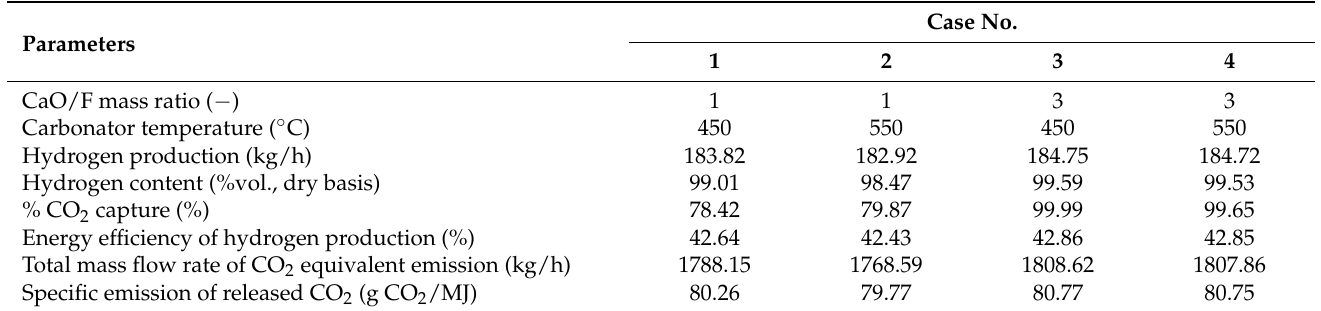
Table 9. Results of the performance analysis and environmental assessment with different conditions of carbonator temperatures and CaO/F mass